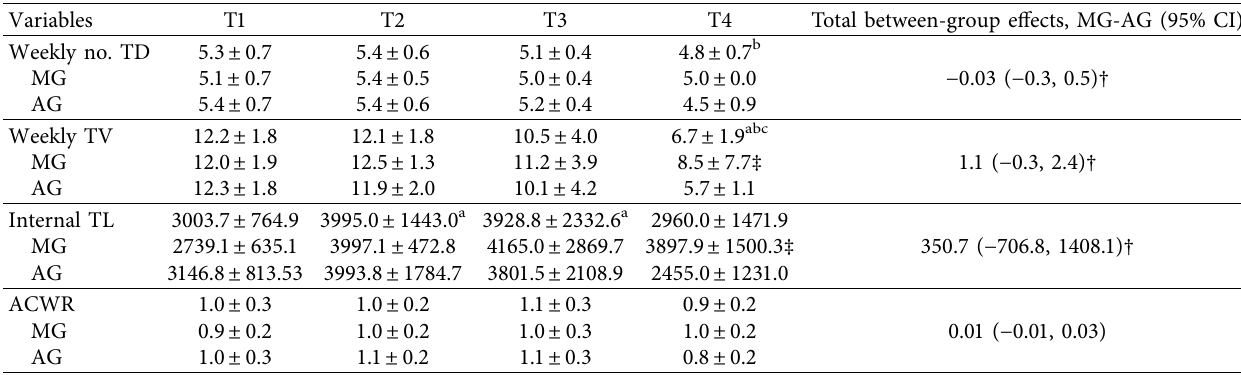
Table 2: Mean ± SD and between-group effects as mean difference (95% confidence interval) for training parameters of participants according to training phases. Weekly no. TD